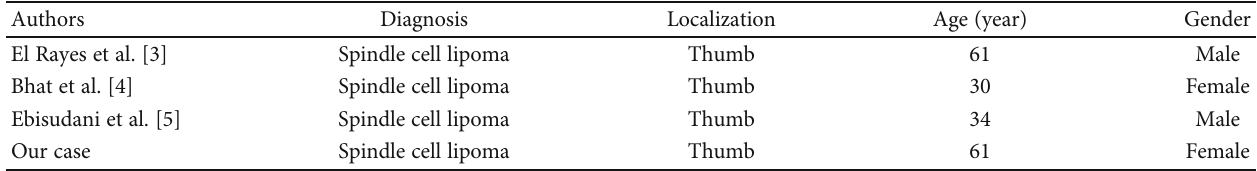
Table 1: The four cases of spindle cell lipoma in